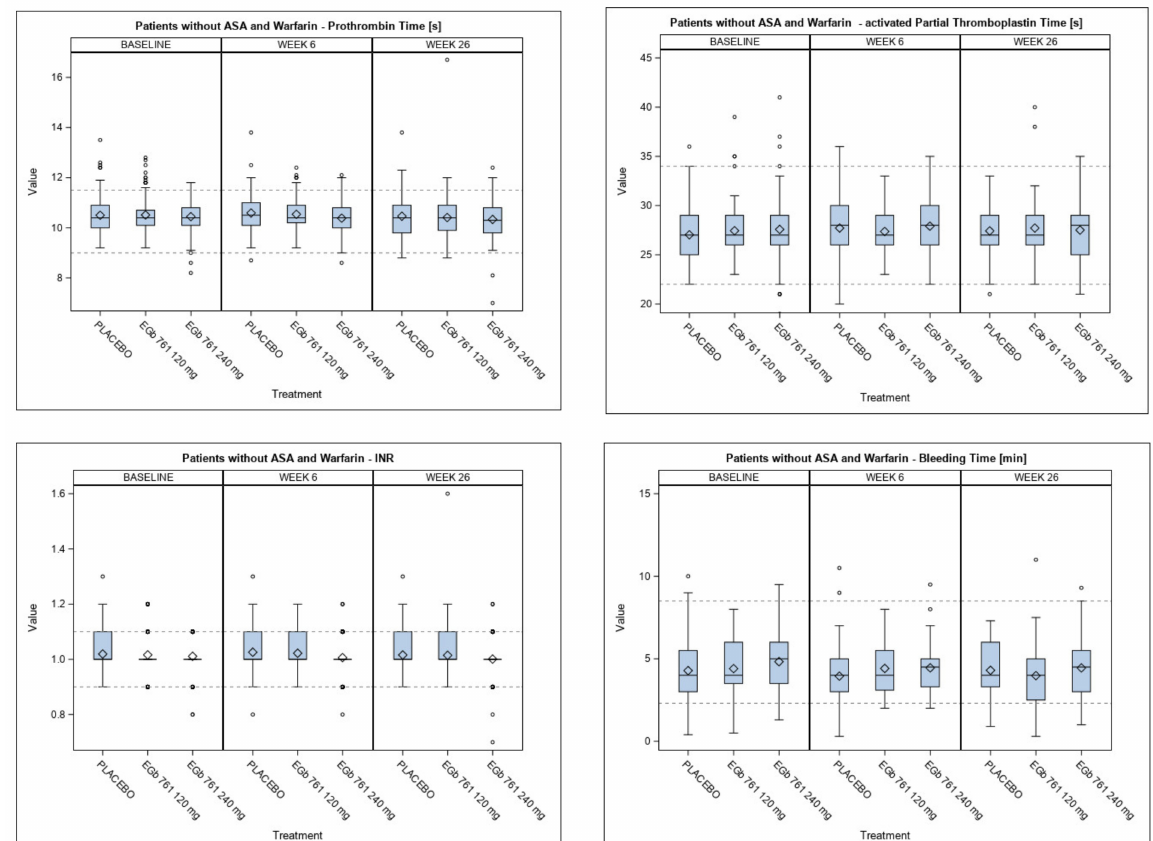
Figure 1. Blood coagulation (prothrombin time [reference range of 9–11.5 s], activated partial thromboplastin time [reference range of 22–34 s], international normalized ratio (INR) [reference range of 0.9–1.1]) and bleeding time [reference range of 2.3–8.5 min]) in subjects taking neither acetylsalicylic acid (ASA) nor warfarin as concomitant medication at baseline, 6 weeks and 26 weeks (endpoint). Box-and-whiskers plots showing the mean (diamond), median (line within the box), interquartile range [IQR] (box), range within 1.5xIQR (whiskers), values without 1.5xIQR (circles). All p -values for pairwise comparisons between the active treatment groups and placebo at week 26 are not